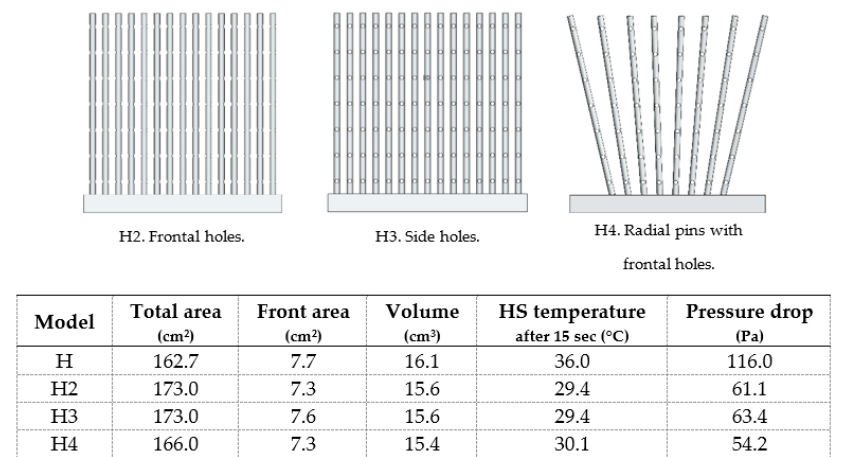
Table 9. Temperature and pressure drop for each pin heat sink model.